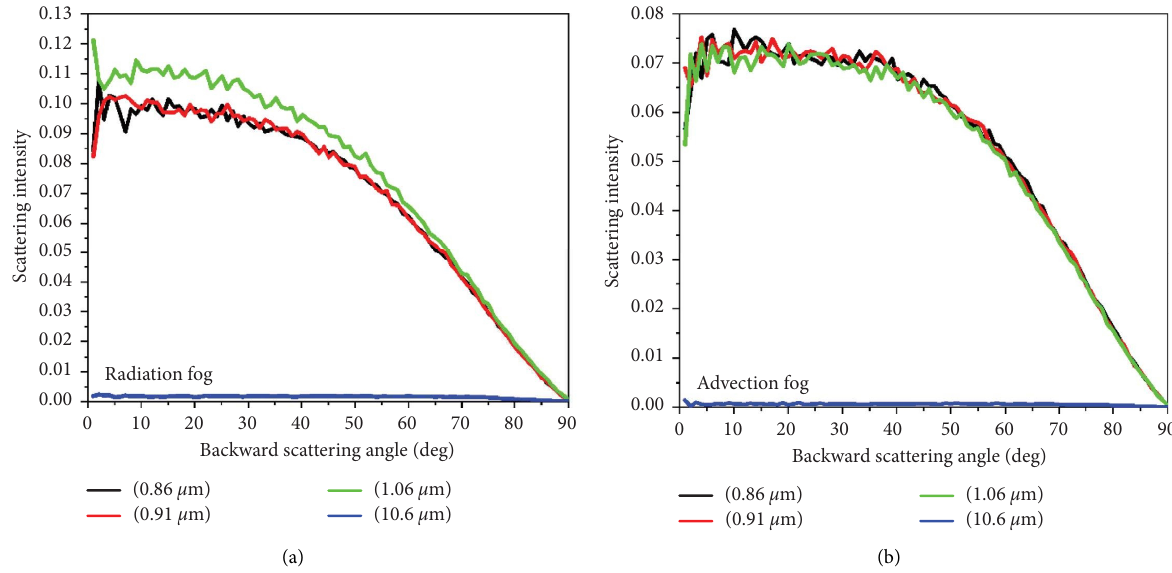
Figure 7: Te backscattering intensity versus scattering angle for diferent